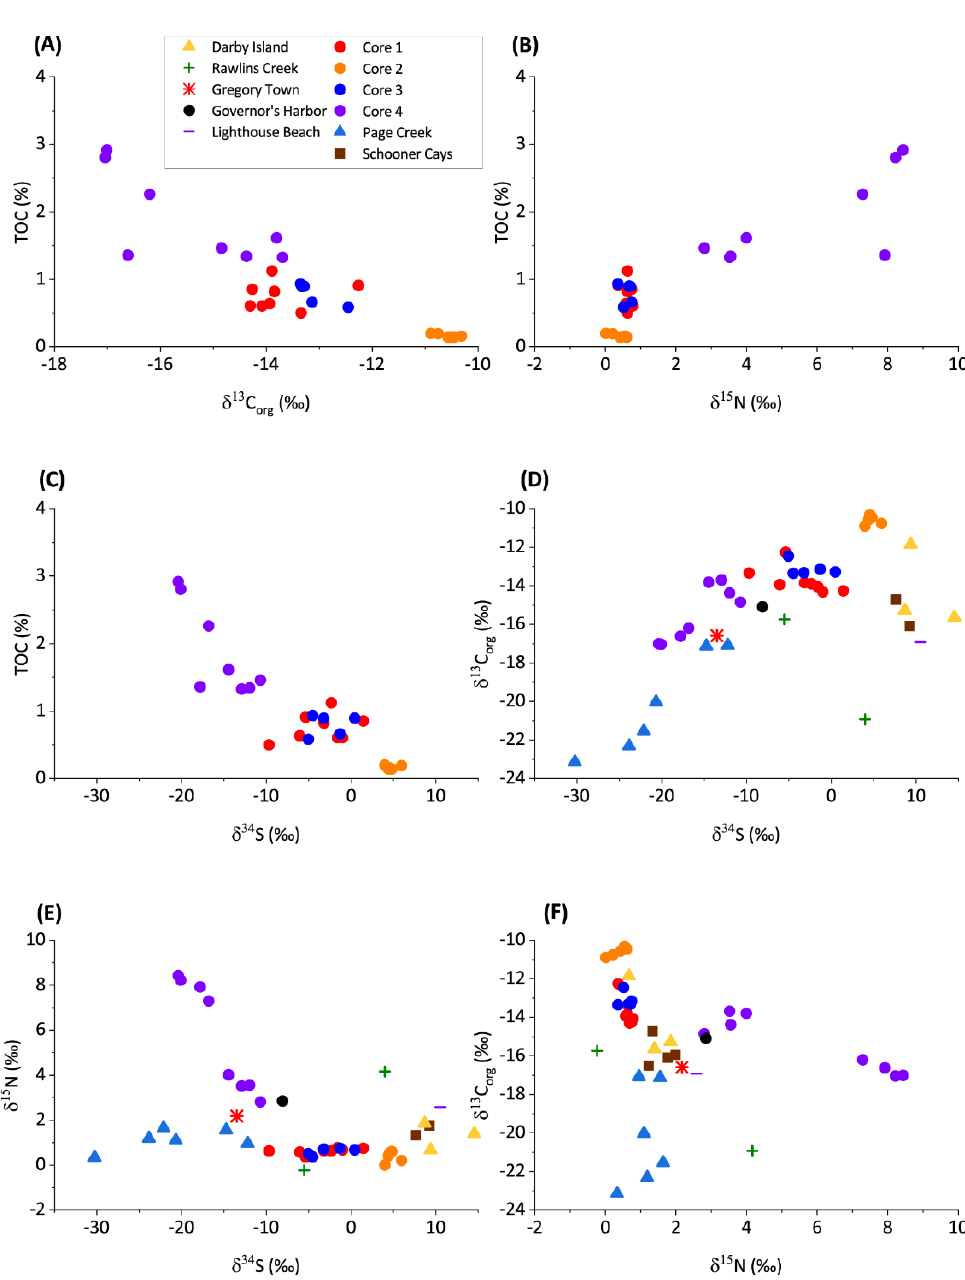
Figure 3. Cross plots of stable isotopes of the de ‐ calcified organic residual material, indicating vari ‐ ous attributes of the diagenetic circumstances during deposition. ( A ) TOC versus δ 13 C org . ( B ) TOC versus δ 15 N org . ( C ) TOC versus δ 34 S. ( D ) δ 13 C org versus δ 34 S. ( E ) δ 15 N org versus δ 34 S. ( F ) δ 13 C org versus δ 15 N org .